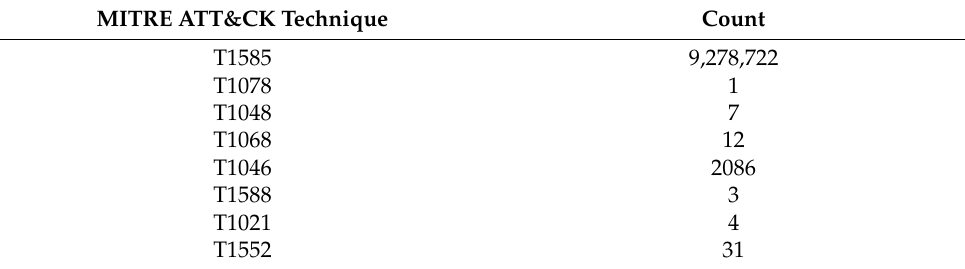
Table 2. Conn log breakdown by MITRE ATT&CK